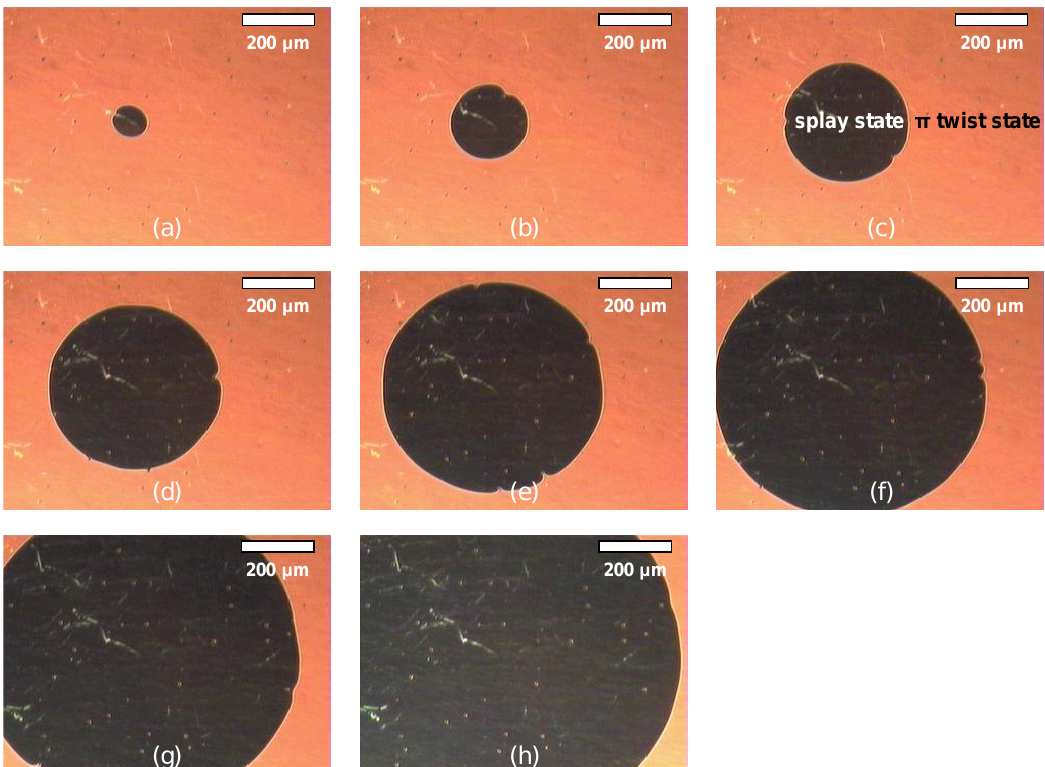
Figure 3. Phase transition from the initial twist state to the splay state observed at ( a ) 6 s, ( b ) 9 s, ( c ) 12 s, ( d ) 15 s, ( e ) 18 s, ( f ) 21 s, ( g ) 24 s, and ( h ) 27 s.